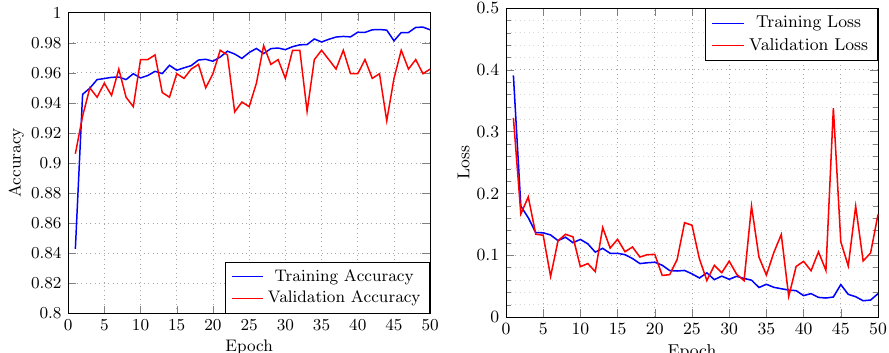
Figure 6. The overall performance of the LW-FIRE150 42 model with the highest accuracy on the testing set: training and validation accuracy ( left ) and loss ( right ).